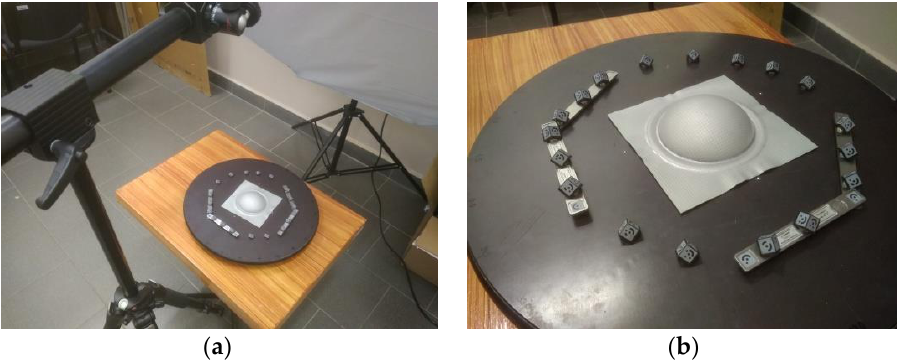
Figure 4. ARGUS measuring system ( a ) and a sample prepared for measurement ( b